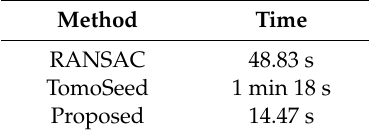
Table 3. Time cost. Processing times are obtained by a regular desktop PC (Core i5-7200U). The time does not include the time expended on data splitting and splicing in RANSAC and TomoSeed.